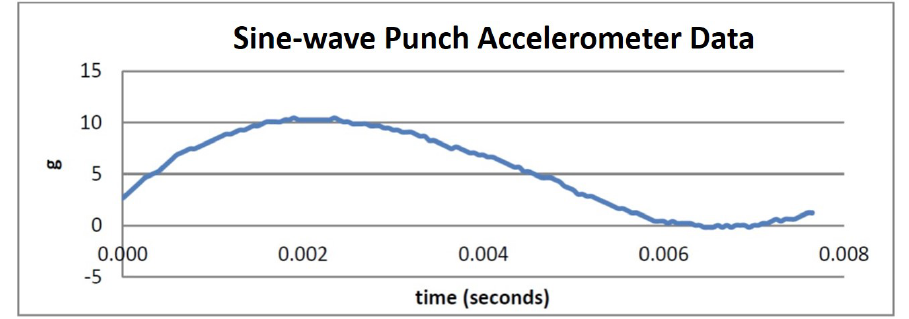
Figure 7. Sine-wave punch accelerometer data.